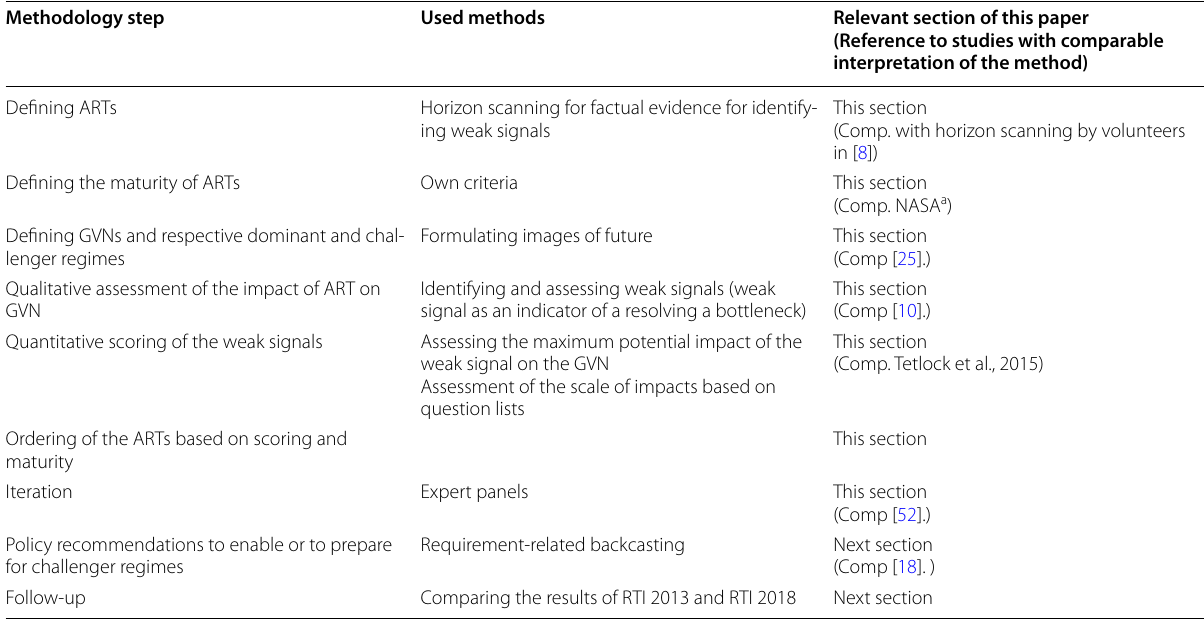
a https:// www. nasa. gov/ direc torat es/ heo/ scan/ engin eering/ techn ology/ techn ology_ readi ness_